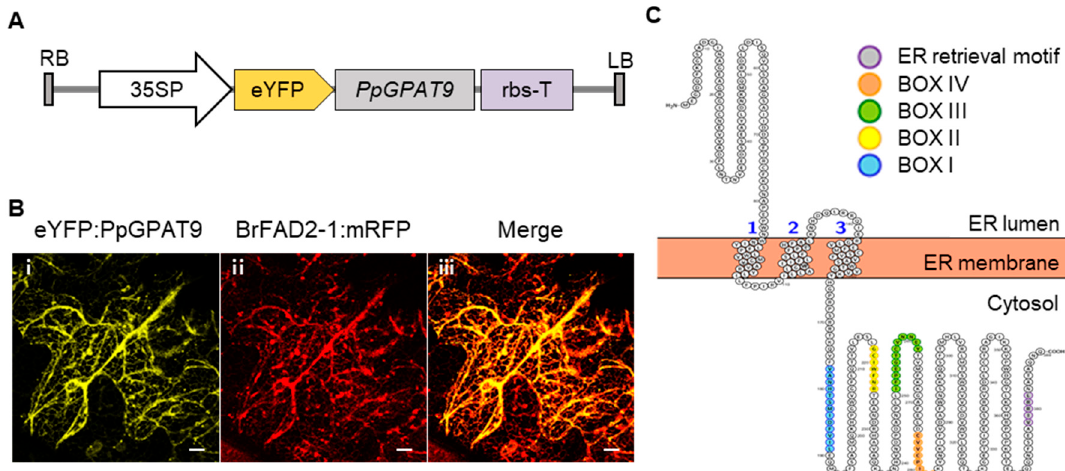
Figure 3. Subcellular localization of PpGPAT9. (A and B) Subcellular localization of eYFP:PpGPAT9 in N. benthamiana leaf epidermal cells. ( A ) Binary vector construct harboring eYFP:PpGPAT9. 35SP, cauliflower mosaic virus 35S promoter. eYFP, enhanced yellow fluorescent protein; LB, left border; RB, right border; rbs-T, terminator of ribulose-1,5-bisphosphate carboxylase and oxygenase small subunit from pea ( Pisum sativum ). ( B ) Two fluorescent signals in N. benthamiana leaf. Agrobacterium tumefaciens cells harboring eYFP:PpGPAT9 and BrFAD2-1:mRFP were co-infiltrated into N. benthamiana leaf epidermal cells. The fluorescent signals were visualized under a confocal laser-scanning microscope at 48 h after infiltration. (i) Yellow fluorescent signals from eYFP:PpGPAT9. (ii) Red fluorescent signals from BrFAD2-1:mRFP. (iii) Merged image of eYFP:PpGPAT9 with BrFAD2-1:mRFP. Bars = 10 μ m. ( C ) Topology of PpGPAT9. The topology of PpGPAT9 was analyzed using the open-source tool for visualization of proteoforms (http://topcons.net/;